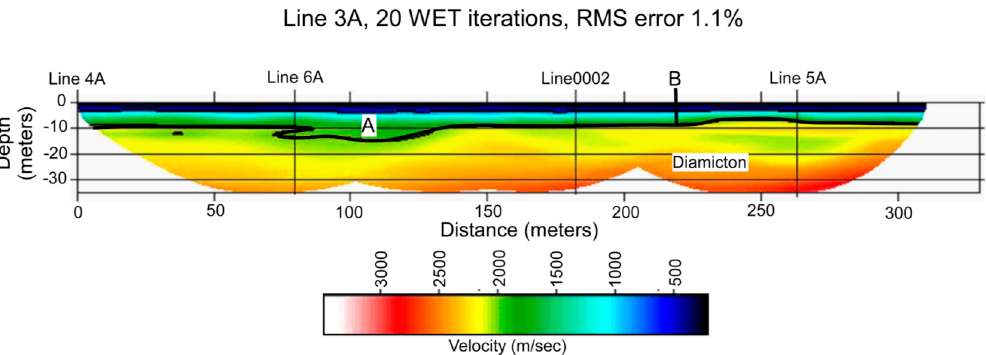
Figure 11. North-South velocity profile of Line 3A with geologic interpretation. South is to the left. A = Channel position; B = terrace elevation.